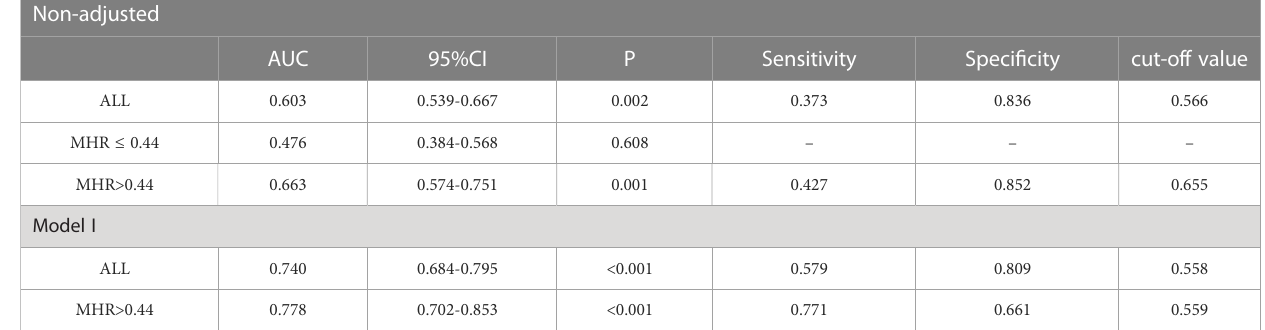
TABLE 5 ROC curve analyses of different levels of MHR.